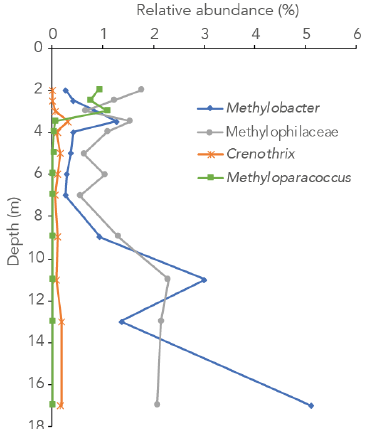
Figure 3. Relative abundance of 16S rRNA gene sequences anno- tated to the methanotrophic genera Methylobacter , Methylopara- coccus and Crenothrix and the methylotrophic family Methylophi- laceae in the water column of Lake Lovojärvi.